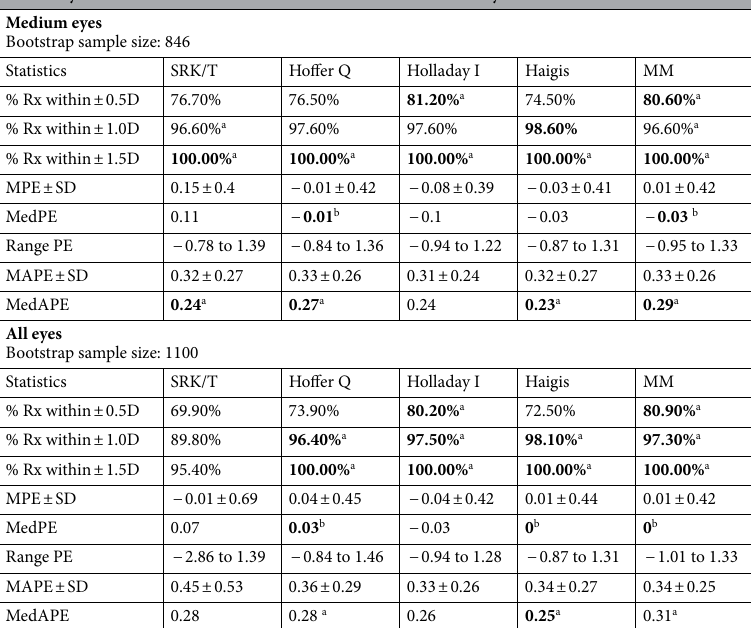
Table 9. Summary statistics of the cross-validation results for each of the five formulae (SRK/T, Hoffer Q, Holladay I, Haigis and MM) for medium and all eyes. % Rx Percentage of eyes within a given range of prediction error, MPE Mean prediction error, MedPE Median prediction error, Range PE Range of the prediction error, MAPE Mean absolute prediction error, MedAPE Median absolute prediction error, SD Standard Deviation of the error. a No statistically significant difference at level 0.05. b No statistically significant difference from zero at level 0.05. Significant values are in